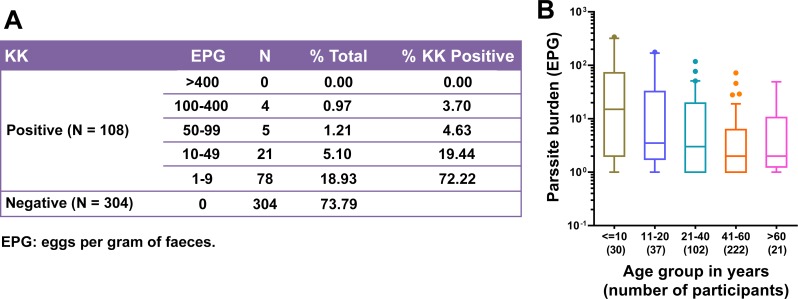
Classification of S. japonicum infection in the study cohort according to parasite load.A) Infection status and intensity determined by the KK method. B) Parasite load (EPG) in the different age groups. Boxes represent the interquartile range of the data with lines across the boxes indicating the median values. The hash marks above and below the boxes indicate the 90th and 10th percentiles, respectively. No statistically significant difference was observed between age groups (Non-parametric Kruskal-Wallis test, p > 0.05).